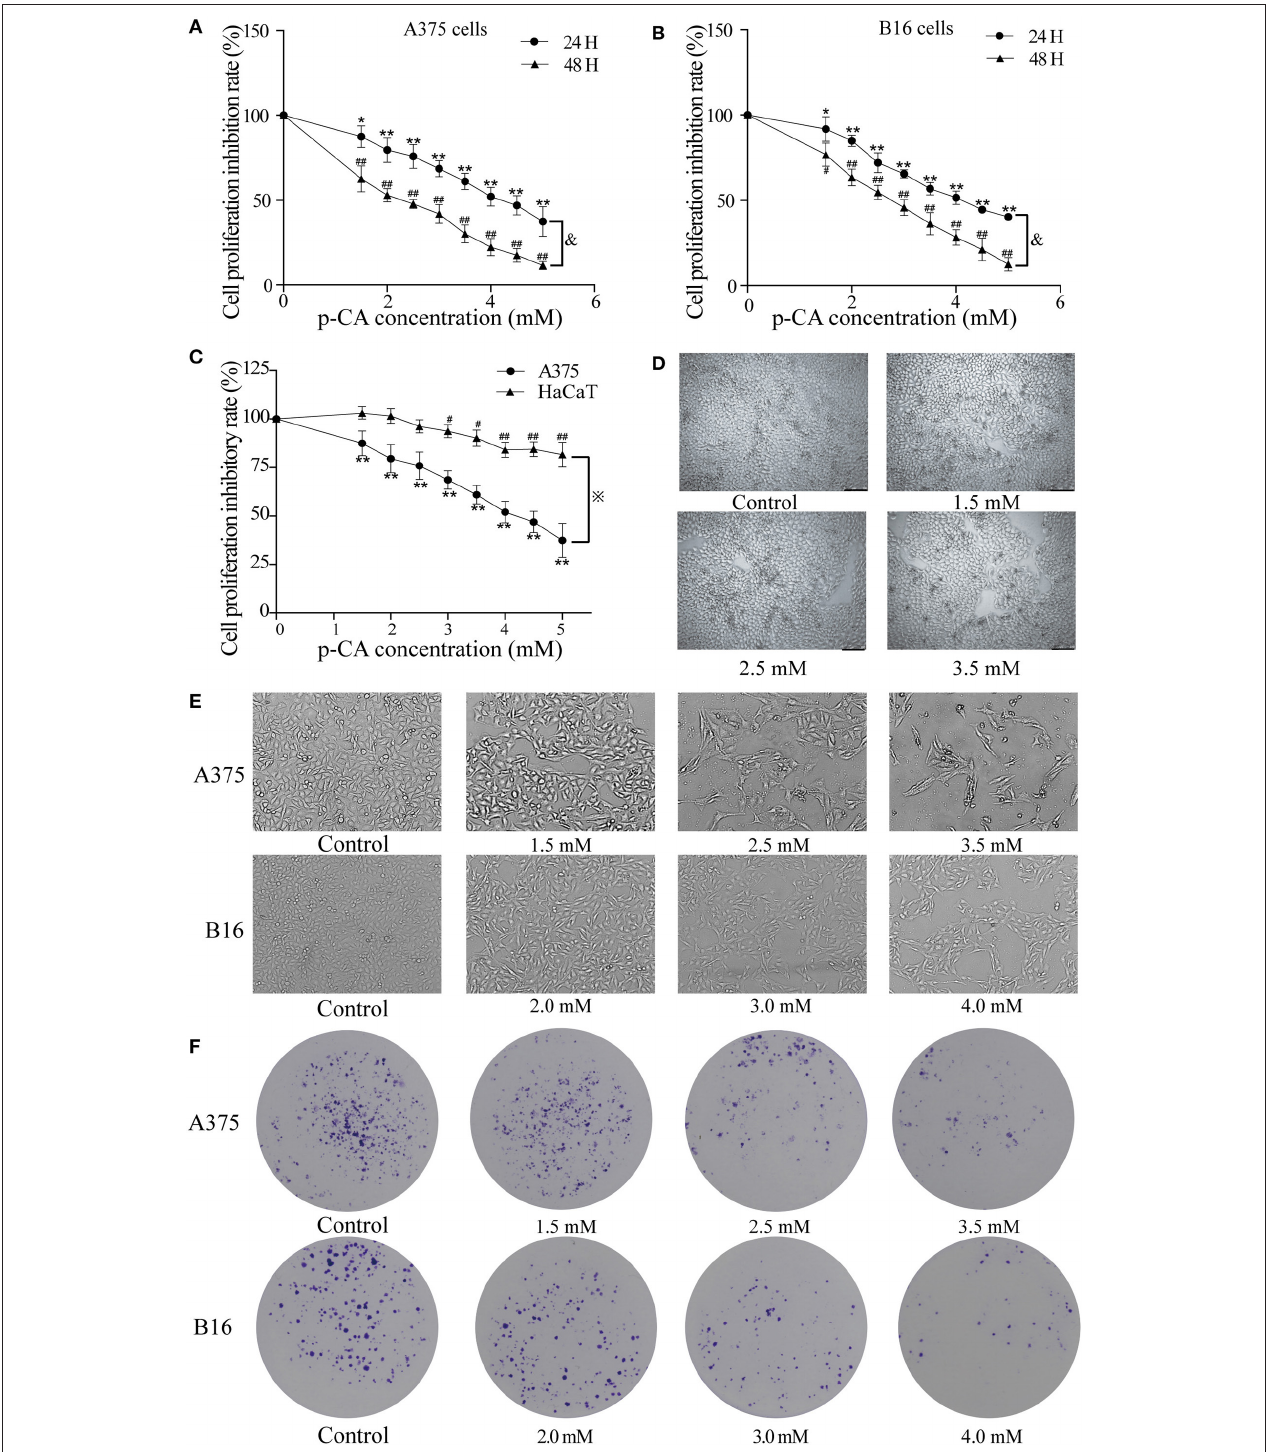
FIGURE 1 | p -CA inhibits proliferation and colony formation of A375 and B16 cells. (A,B) A375 and B16 cells were treated with p-CA. After incubation for 24 or 48h, the proliferation rates of A375 and B16 cells were measured by CCK-8 assay. (C) HaCaT, A375 and B16 cells were treated with p -CA. After incubation for 24h, the proliferation rates of HaCaT, A375 and B16 cells were measured by CCK-8 assay. (D) Morphological changes of p-CA-treated HaCaT cells were observed under a phase contrast microscope. (E) Morphological changes of A375 and B16 cells were observed under a phase contrast microscope. Scale bar, 50 µ m. (F) The cell colonies were stained with crystal violet and observed under an inverted microscope. All data are expressed as the mean ± SD of three independent experiments. & P < 0.05 compared with the A375 or B16 cells after p -CA treatment for 24h. * P < 0.05, ** P < 0.01, # P < 0.05, ## P < 0.01 compared with the control.